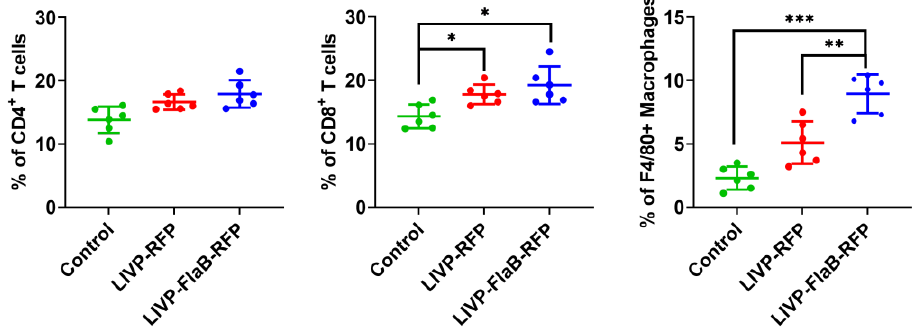
Figure 9. Analysis of tumor infiltrating lymphocytes/macrophages. B16 melanoma tumor samples were collected 72 hours after treatment to evaluate the levels of F4/80 + , CD4 + , and CD8 + cells. For statistical analysis, ANOVA was performed; * p < 0.05, ** p < 0.01; *** p < 0.001 indicates significance.